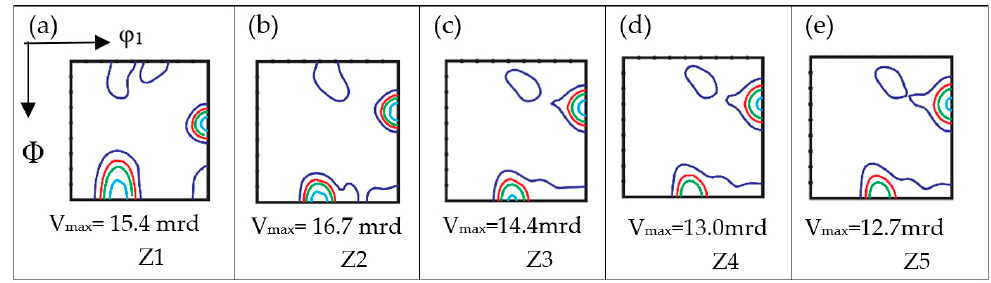
Figure 6. ODF sections in increments of φ 2 = 45° measured by synchrotron radiation for Al in rectangular cold extruded Al60Mg40. ( a ) 1 mm, ( b ) 3.15 mm, ( c ) 5.3 mm, ( d ) 7.45 mm, ( e ) 9.16 mm below the surface.